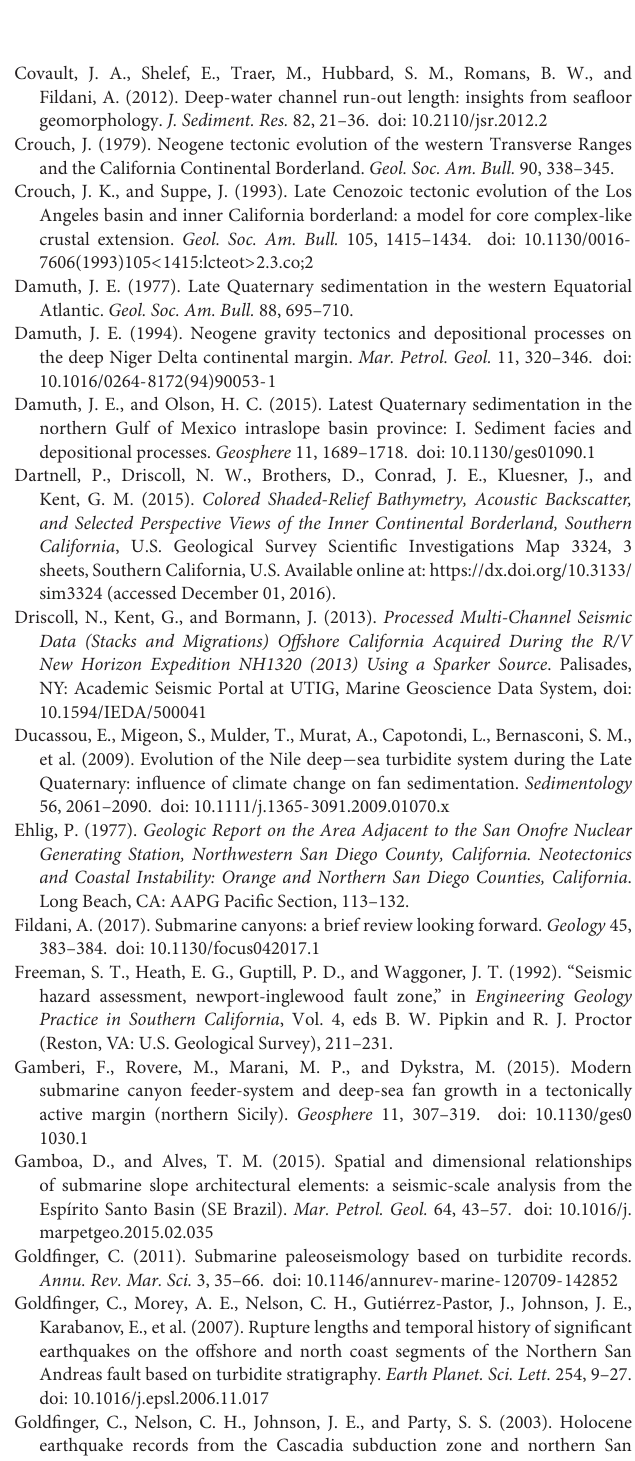
FIGURE S1 | Age-depth models of all cores. Plotted are the median age, the 95% confidence interval, and the probability density function of the calibrated age. Sand layers are shown in horizontal gray bars. FIGURE S2 | Sparker seismic dip profiles offshore of San Onofre. Profiles are organized with the northernmost profile at the top and southernmost profile at the